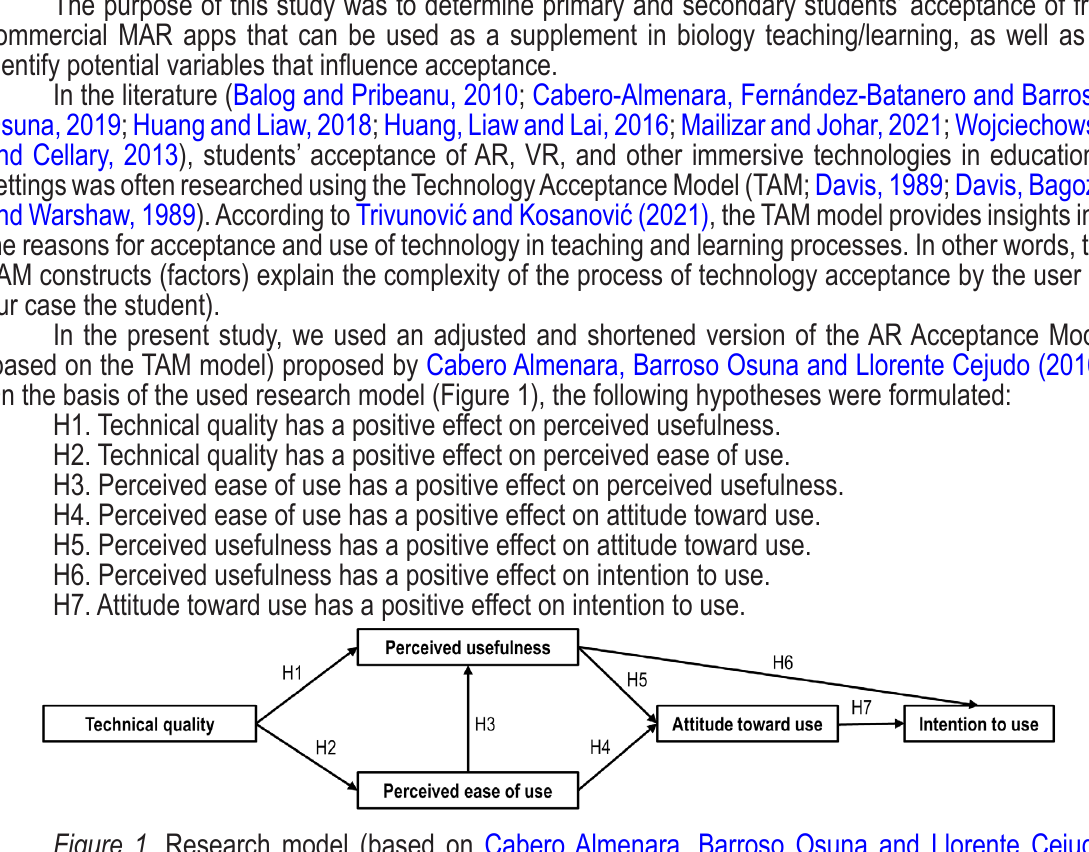
Figure 1. Research model (based on Cabero Almenara, Barroso Osuna and Llorente Cejudo,